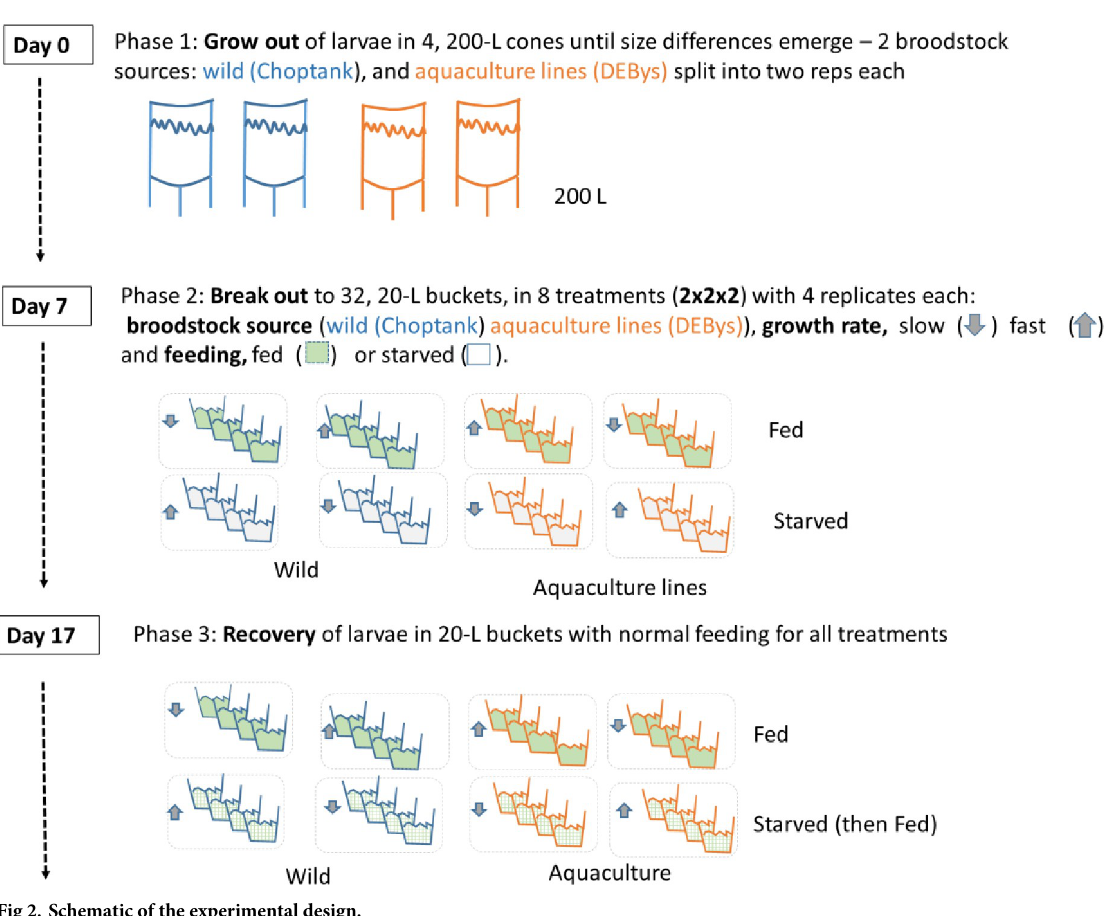
software. Shell lengths of 30 individuals were measured per replicate bucket, except in cases